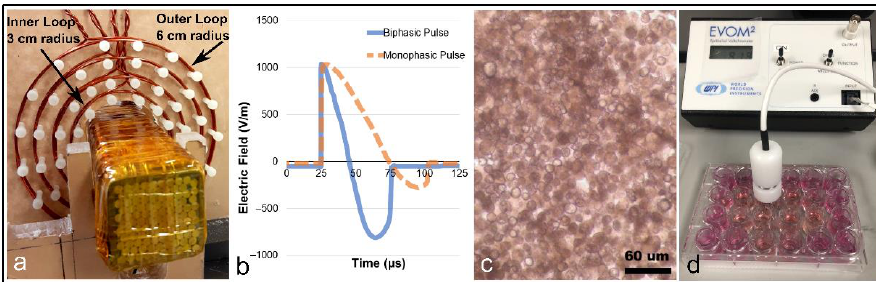
Figure 2. EPM assembly electric field measurements, Caco-2 cultures, and TEER measurement apparatus. ( a ) Electropermanent magnet assembly and coated copper wire windings, centered in an electric-field measurement device composed of concentric coils. The electric field generated by pulsing the EPM assembly is quantified by measuring the voltage induced across the coils. ( b ) The induced electric field for biphasic and monophasic pulses. As can be seen in ( b ), the monophasic pulses (orange dotted line) induce only a one-directional electric field, while the biphasic pulses (solid blue line) induce bi-directional electric fields. ( c ) Caco-2 cells cultured on transwell membranes prior to TEER measurements. ( d ) Apparatus and technique for TEER measurements of the BBB tight junction